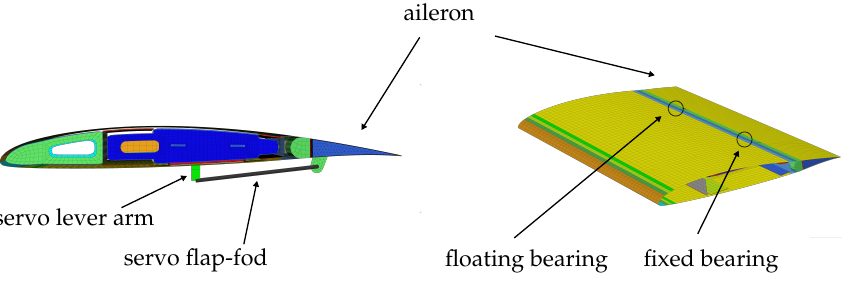
Figure 6. FEM modeling of the ailerons.